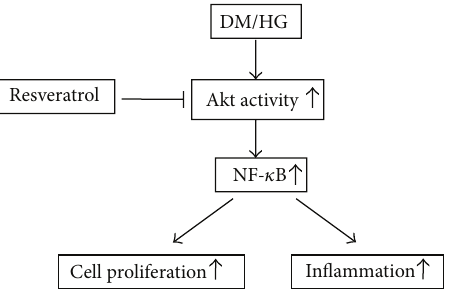
Figure 7: Schematic representation of proposed intracellular sig- naling leading to renoprotective potential of resveratrol against hyperglycemia-mediated inflammation and mesangial cell prolifer- ation in